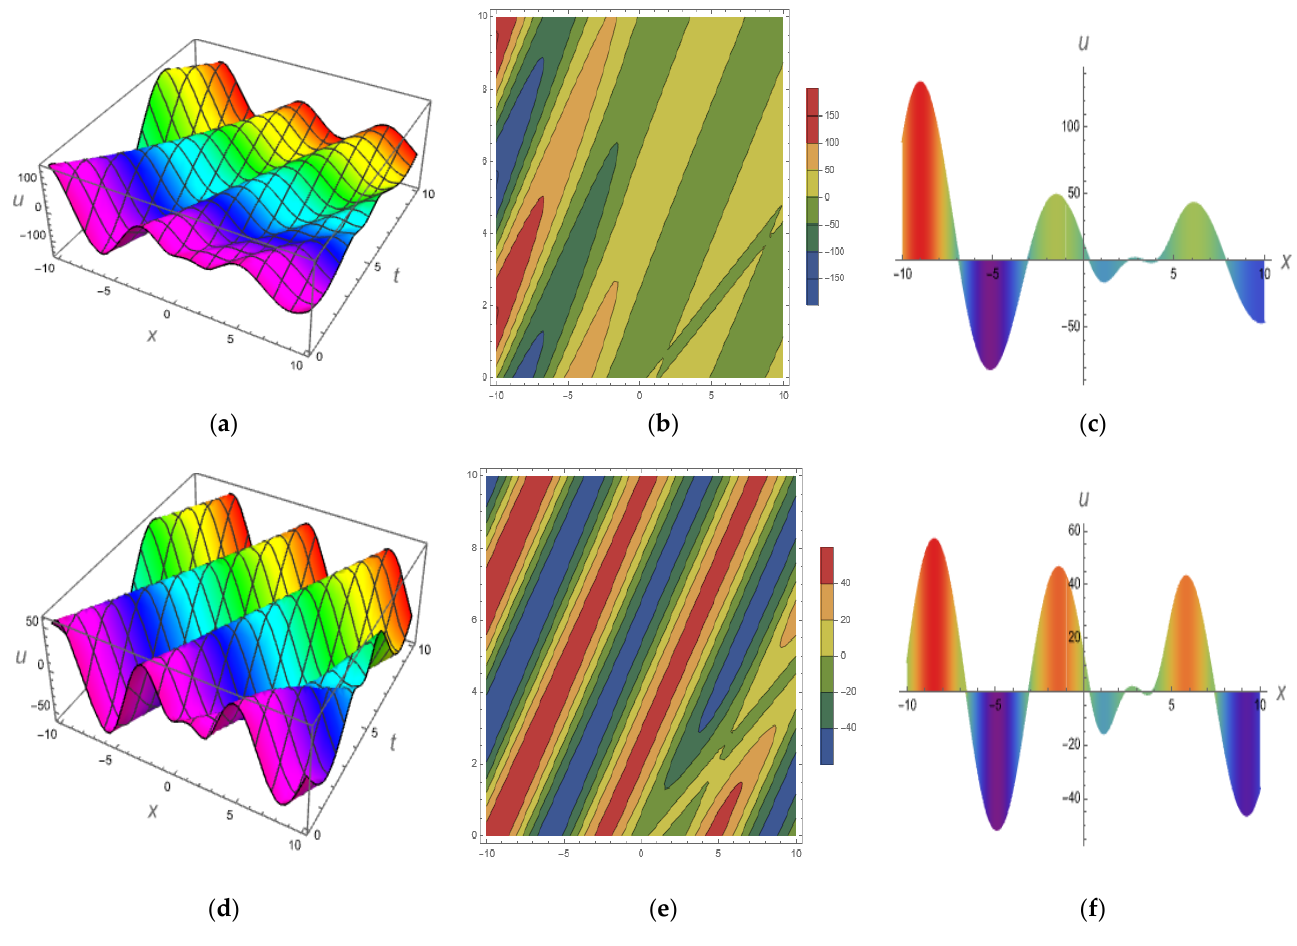
Figure 2. This figure presents the impact of fractional order on the solution Re ( U 1,1 ( x , t )) at a = 1,w = 0.9, P = 0.9, k = 0.9, c = 1, N = 0.7, a 0 = 2, a 2 = 11.56449544 I , ν = 0.1. ( a ) 3D visualization at α = 0.95. ( b ) Contour visualization at α = 0.95. ( c ) 2D visualization at α = 0.95. ( d ) 3D visualization at α = 0.99. ( e ) Contour visualization at α = 0.99. ( f ) 2D visualization at α = 0.99.